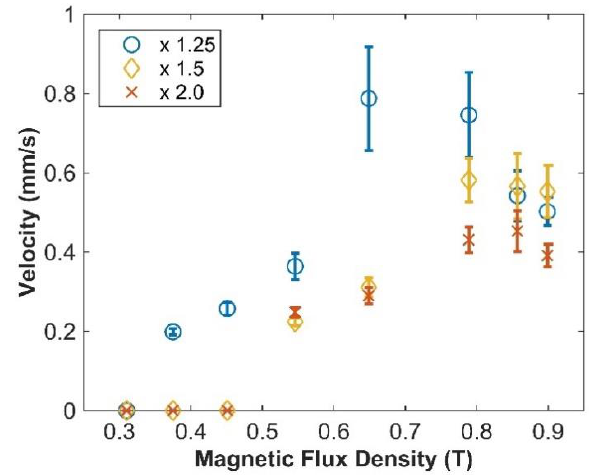
Figure 10. Result of the walking velocity experiment conducted according to the magnetic flux density and varying size of the soft robot.